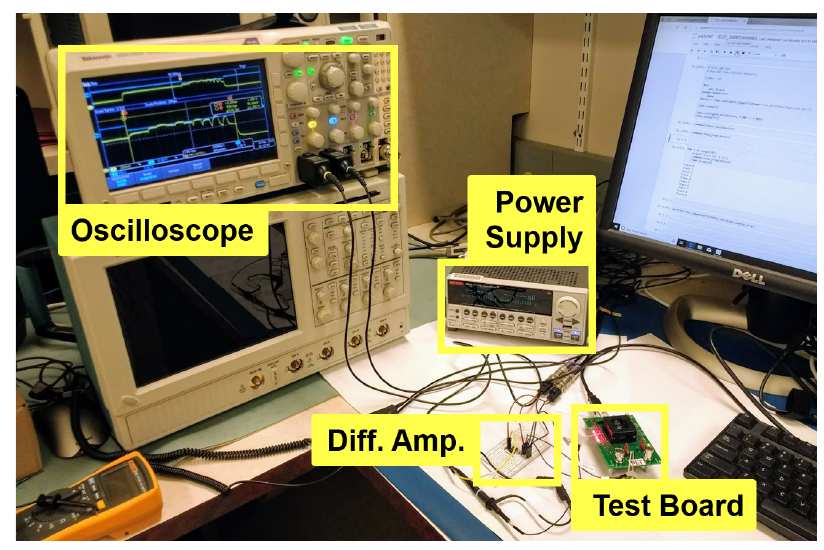
Figure 15: Power side-channel measurement